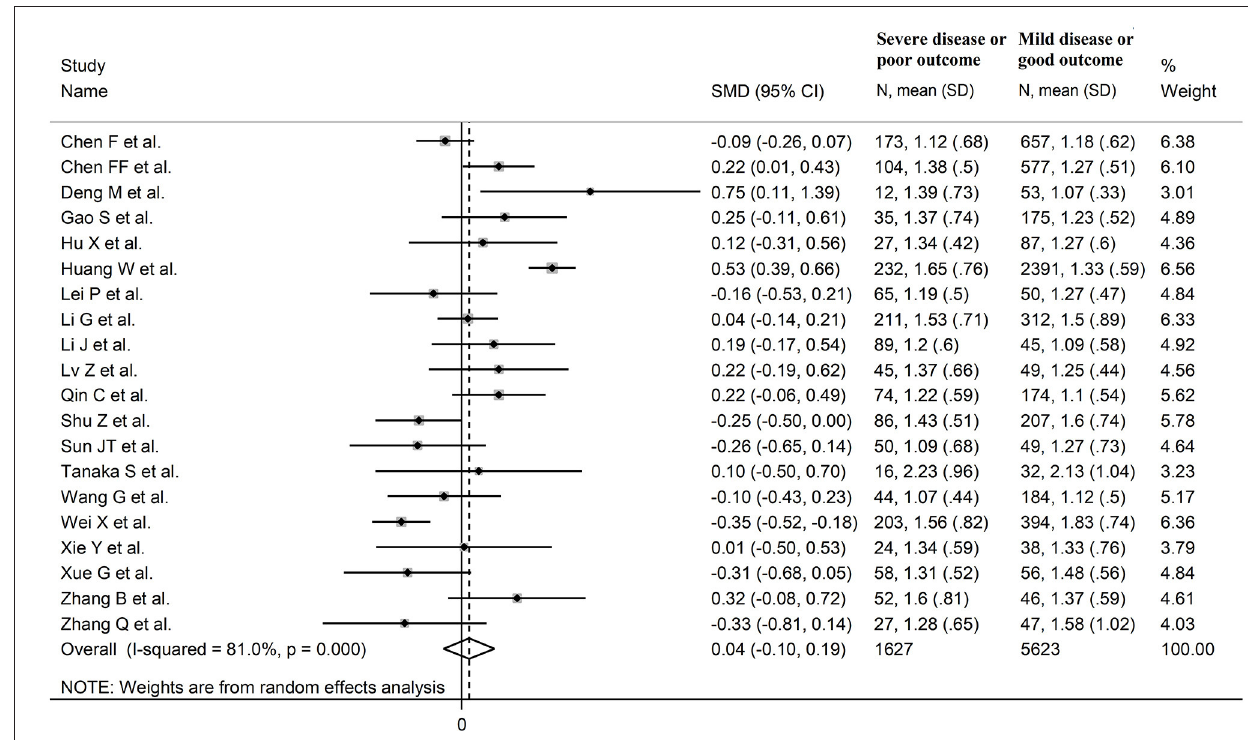
FIGURE 8 | Forest plot of studies examining the concentrations of triglycerides in COVID-19.